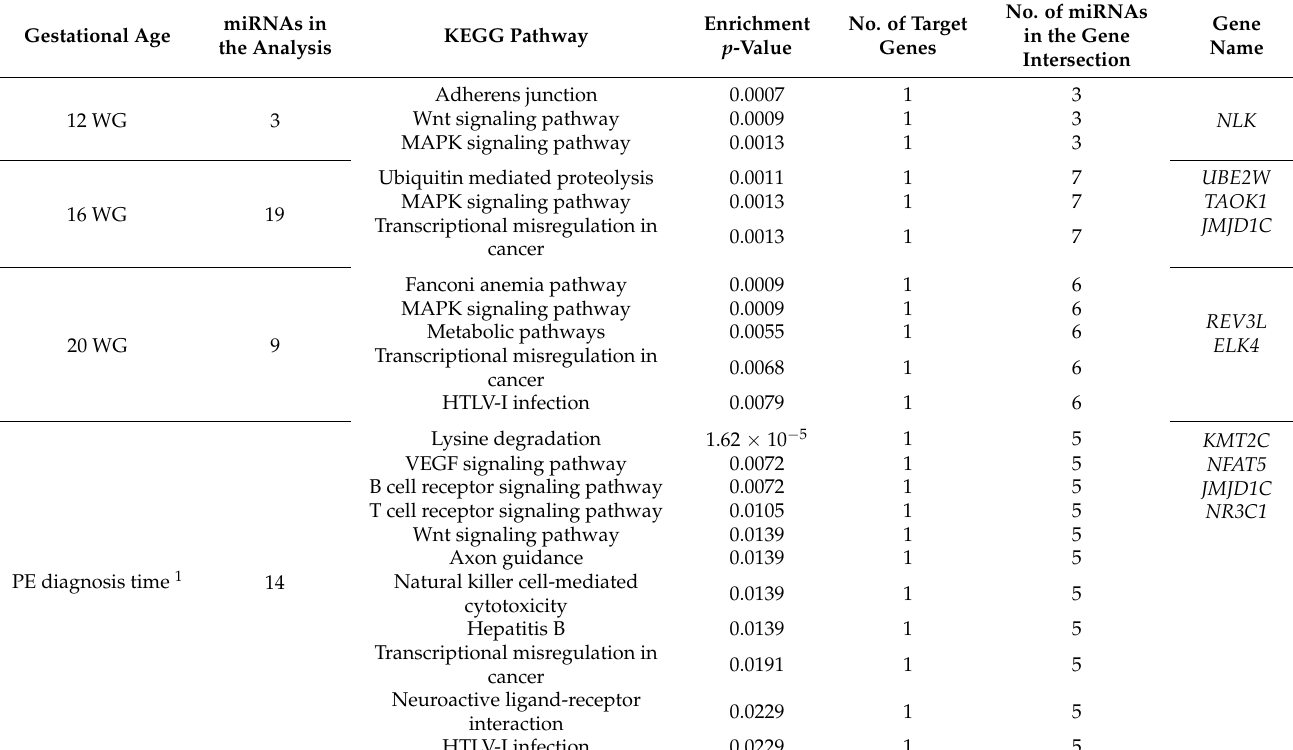
Table 2. Signaling pathway analysis and miRNA target